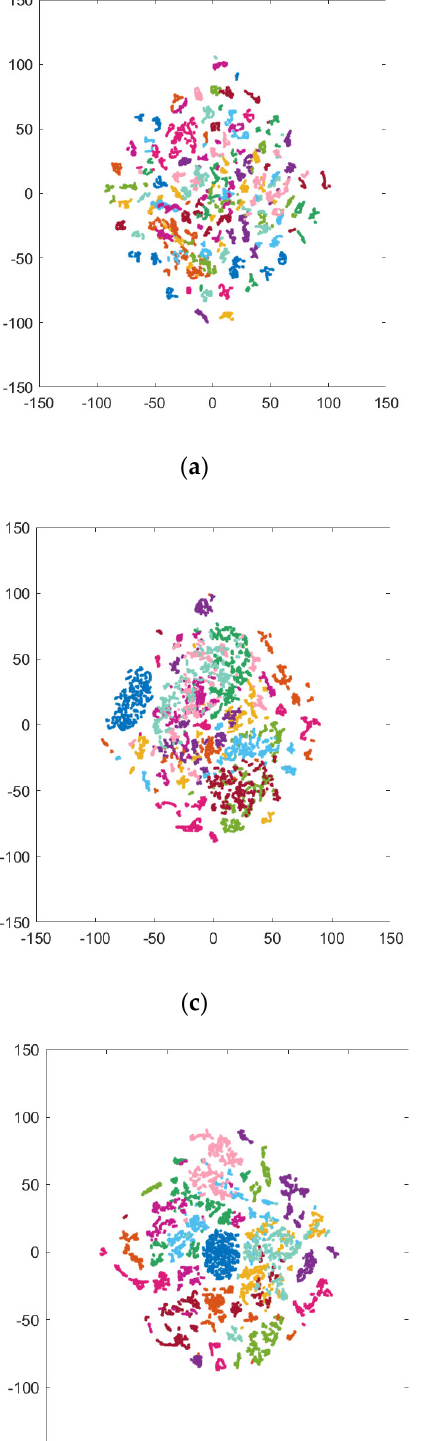
( b ) Figure 8. SC quantification of variability in the sEMG signals: ( a ) healthy adults, ( b ) forearm am- putee. 3.2. Classification Accuracy Tables 2 and 3 show the classification accuracy with MAV only and Hudgins’ fea- ture vector set. The classification accuracies of both the healthy adults and the forearm amputee improved as the number of training sessions increased. Significant improve- ments in the classification performance appeared after six and five training sessions in the healthy adults and forearm amputee, respectively.